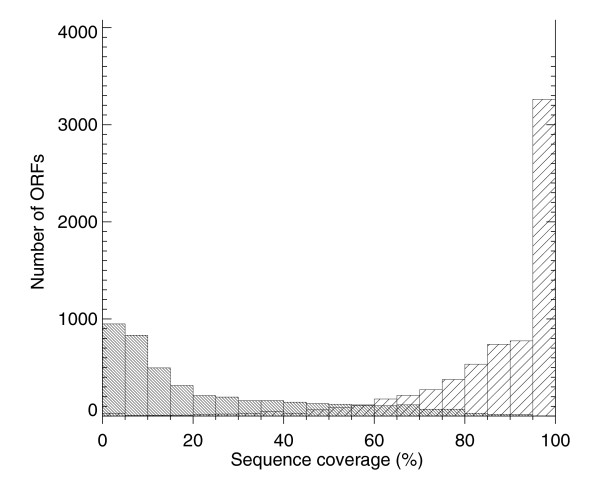
Histrograms of protein sequence coverage. A histogram of the sequence coverage of the S. cerevisiae ORFs by PeptideAtlas (darker filled bars) and an in silico tryptic digestion of the reference protein database with a mass range of 500 to 4,000 Da (lighter diagonal pattern filled bars) is shown. Of the PeptideAtlas ORFs, 61% have coverage below 20%, while 39% have a coverage above 20%.